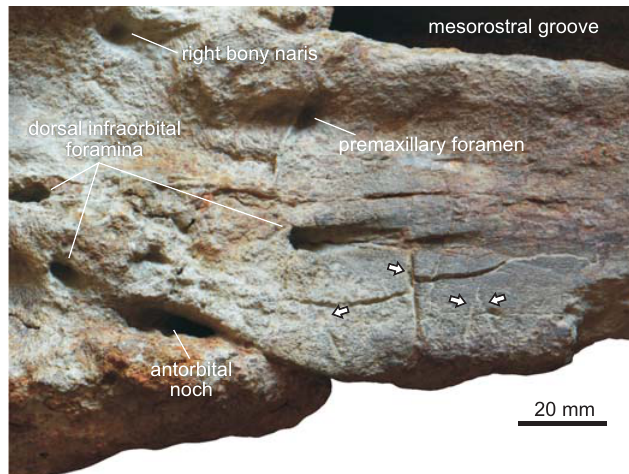
Fig. 6. Close-up of the dorsal surface of the cranium of the kogiid sperm whale Pliokogia apenninica gen. et sp. nov. (MSNUP I-17603, holotype), from the lower Pliocene of Sant’Andrea Bagni (Northern Apennines, northern Italy), showing the shark bite marks that affect the right maxilla